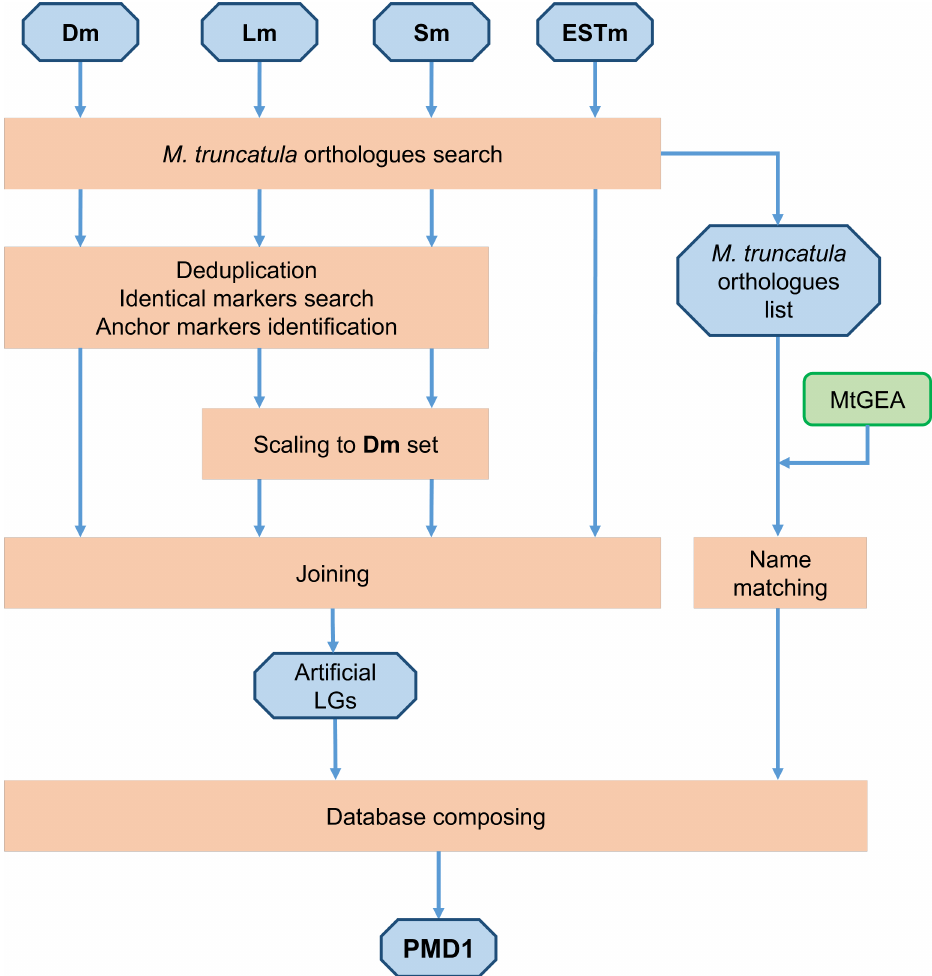
Fig 1. Pipeline of the PMD1 development. Initial and resultingdatasets are placedin blue octagons. Operations are placedin peach-colored rectangles. Steps of PMD1 development are indicatedby arrows. MtGEA means Medicagotruncatula Gene Expression